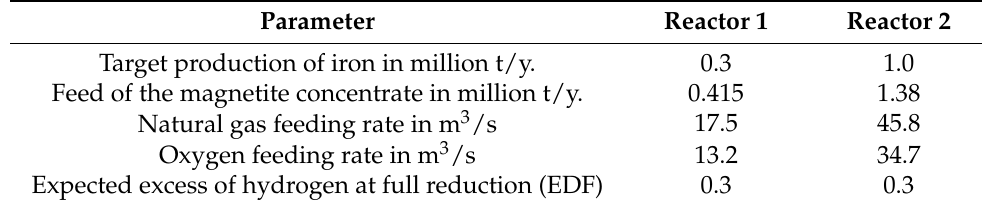
Table 9. Operating conditions of the two industrial reactors.